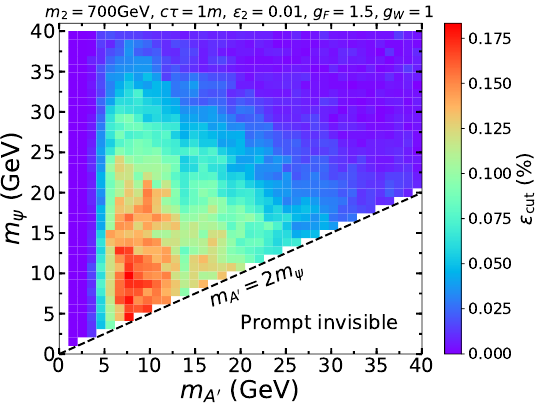
Figure 6 . The cut e(cid:14)ciency (cid:15) cut as a function of m A 0 and m . We set m 2 = 700 GeV, c(cid:28) = 1 m, (cid:15) 2 = 0 : 01, g F = 1 : 5 and g W = 1 : 0.